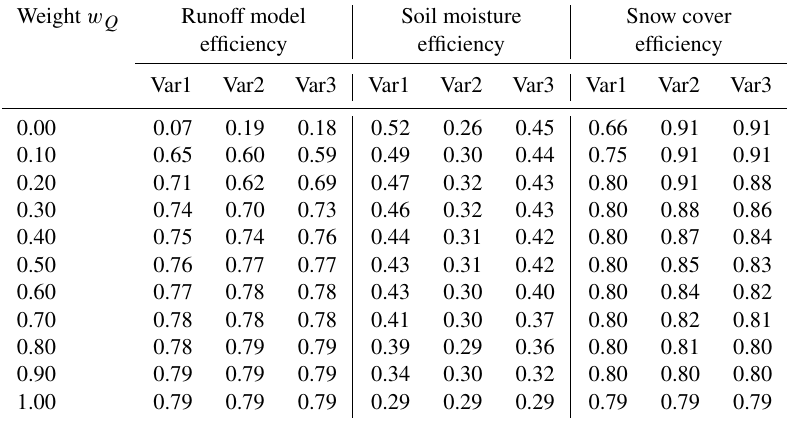
Table 4. Median of runoff (Eq. 2), soil moisture (Eq. 5), and snow cover (Eq. 6) model efficiency obtained from the following three multiple objective calibration variants: (1) satellite soil moisture (ASCAT) and runoff (var1), (2) satellite snow cover (MODIS) and runoff (var2), and (3) satellite soil moisture (ASCAT), satellite snow cover (MODIS), and runoff (var3) in 213 catchments in the calibration period 2000–2010.